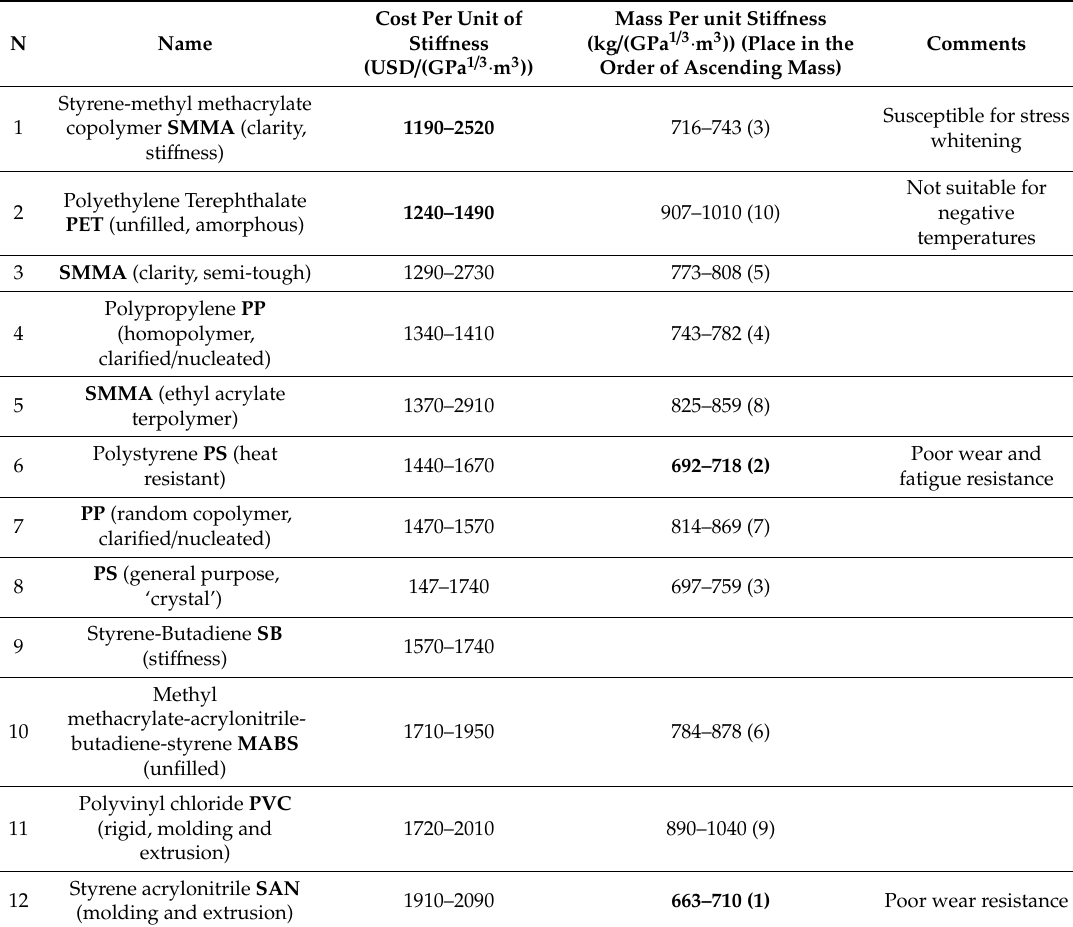
Table 1. Performance of candidate materials (performance indices of two top candidates in respect of relevant performance are given in bold) (Data from CES EduPack 2019, Granta Design Limited, Cambridge, UK, 2019